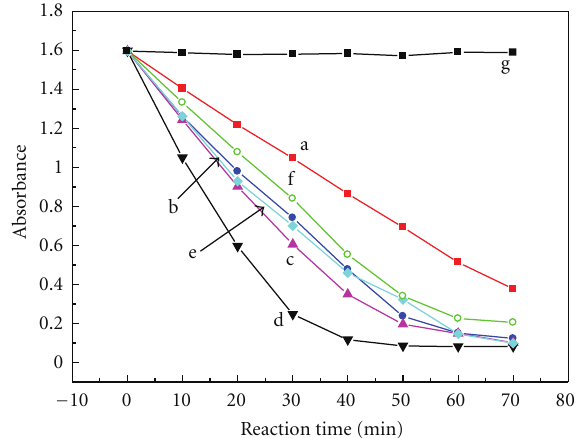
Figure 6: Photodegradation curves of methylene blue for AgBr/ TiO 2 using di ff erent mass ratios of m AgNO 3; (d) 3.35; (e) 3.5; (f) 4; (g) blank.